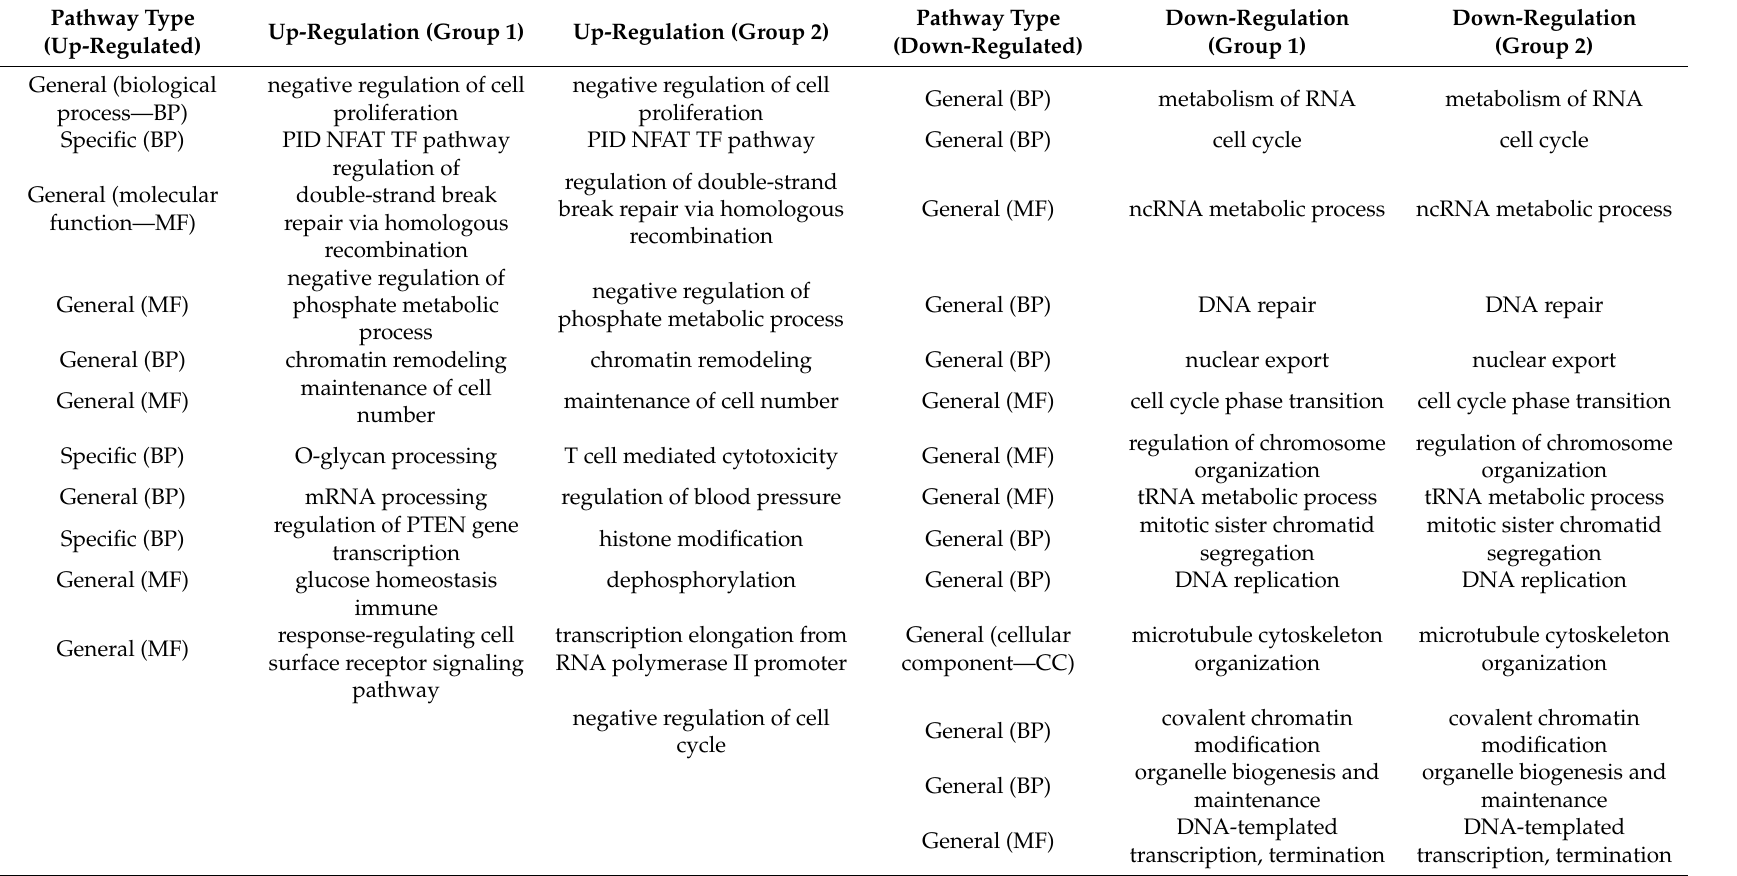
Table 1. Functional and pathway enrichment analysis of identified modules associated with